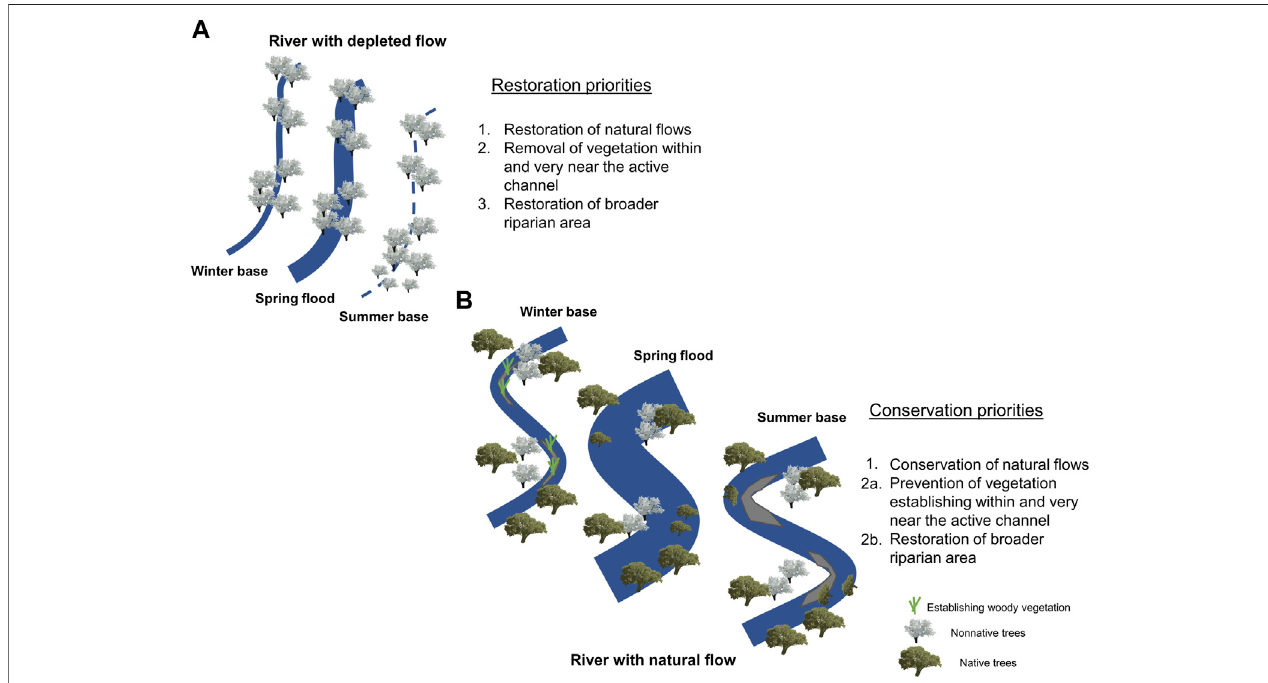
FIGURE 2 | (A) Seasonal regime of a typical desert river with severely depleted fl ow. Non-native vegetation has colonized newly deposited sediments in the fl oodplain and over time has restricted channel movement. Meanwhile, reductions in watershed runoff along with continued depletions lead to some reaches becoming intermittent during summer. The most effective rehabilitation priority in this type of river would be recovery of natural fl ows, particularly large fl oods. Only after that will removal of non-native vegetation and vegetation near the active channel have ecologically and geomorphologically meaningful effects on instream habitat at large spatialextents. (B) Seasonal regime ofadesertriver withnatural fl ows.Thespring fl ood isstilllargeenough toscour active gravelbars ofestablishingwoody vegetation, wet fl oodplain habitat for colonization by and survival of native trees, and cause channel migration and large wood recruitment into the active channel. Here the most effective priority is conservation of natural fl ows with prevention of vegetation establishment within the active channel and rehabilitation of the broader riparian area as equally important and effective secondary